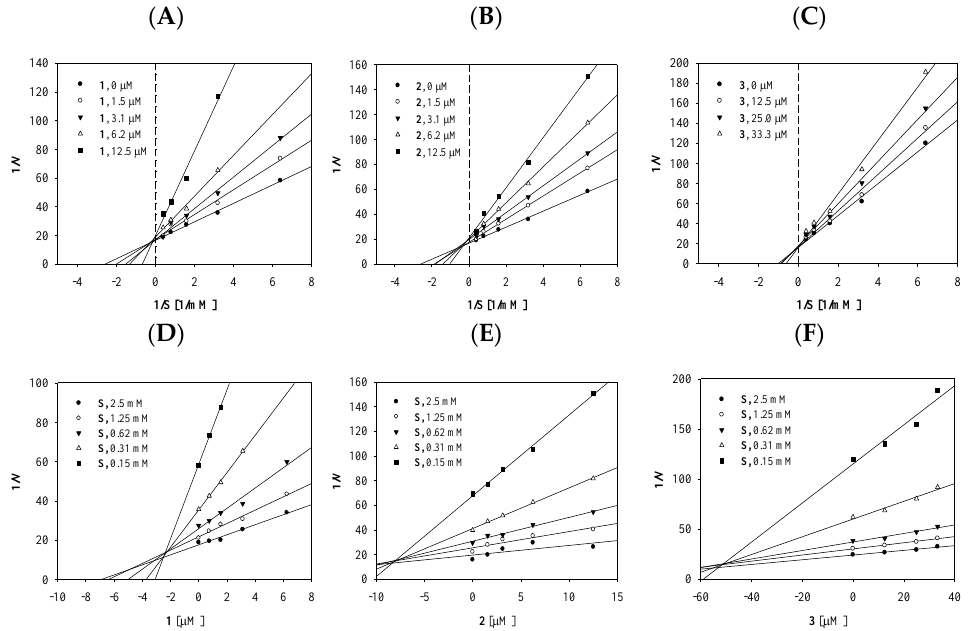
Figure 2. Lineweaver – Burk ( A − C ) and Dixon ( D − F ) plots of inhibitors 1 − 3 , the results were subjected to analysis using Sigma plot 10.0. to analysis using Sigma plot 10.0.